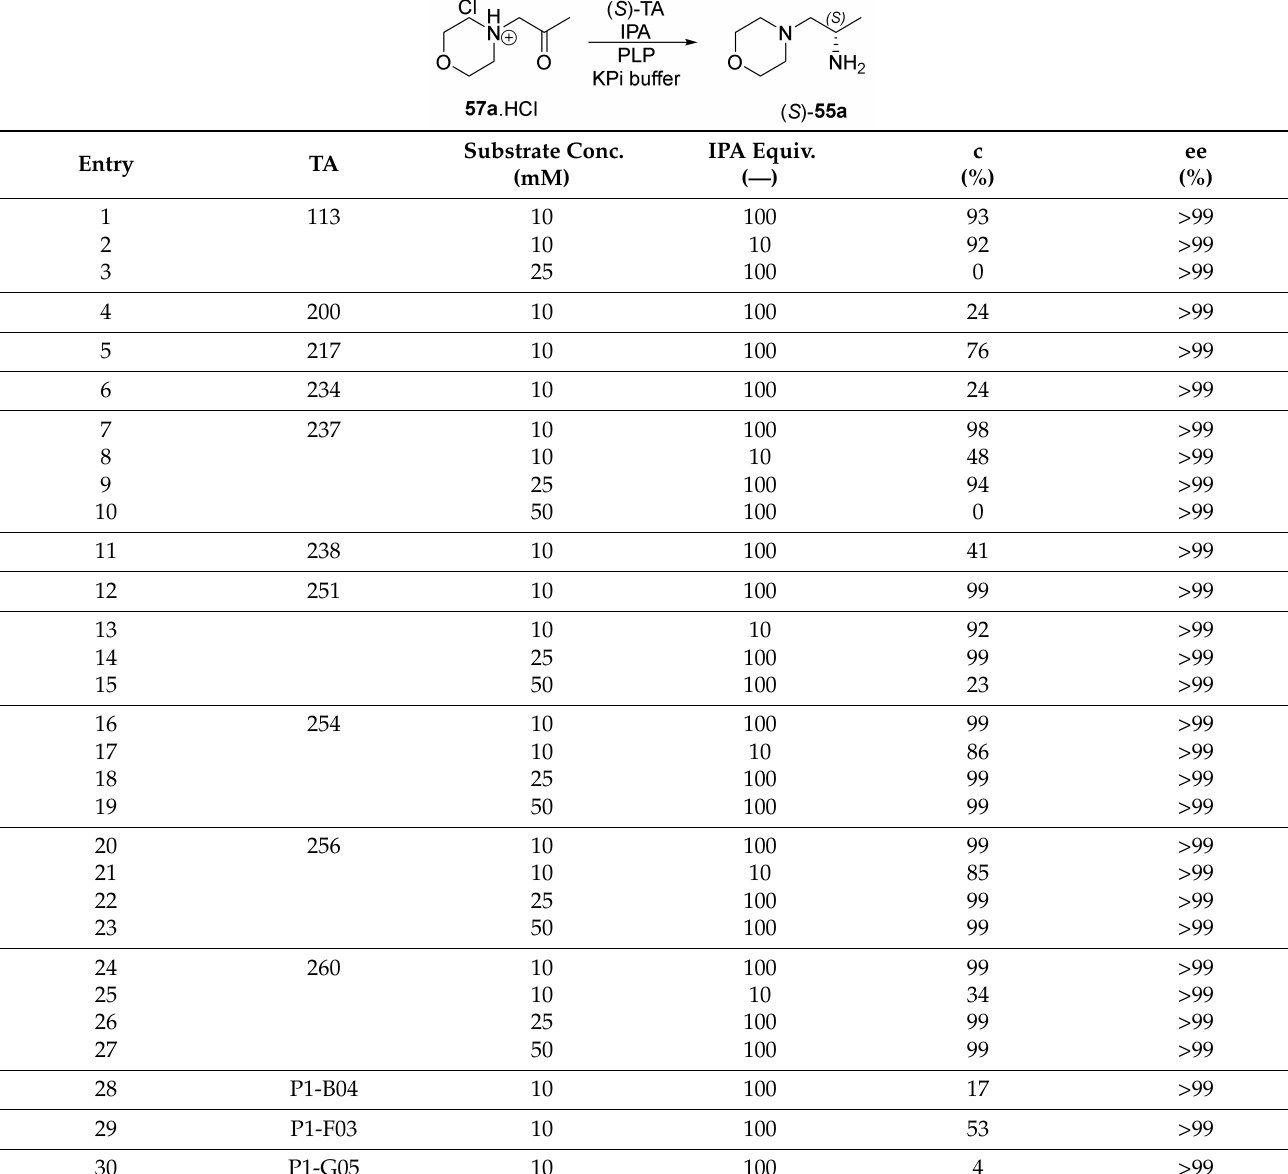
Table 1. Activity screening with the ( S )-selective TAs of the Codex ® Amine Transaminase Screening Kit in transamination of 1-morpholinopropan-2-one ( 57a ).